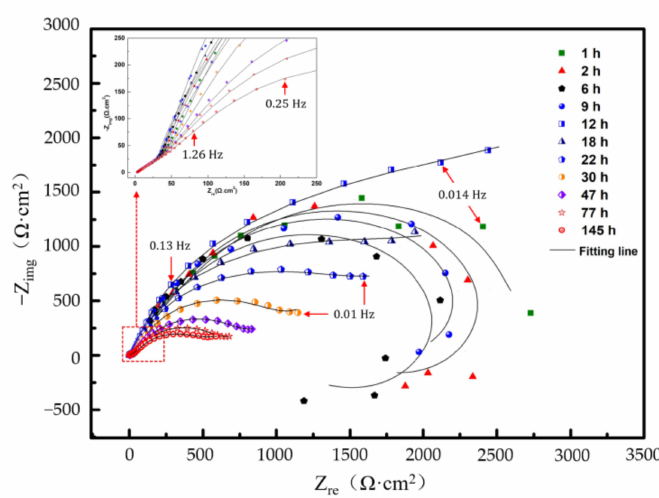
Figure 7. Nyquist plots of the Al–BN ACS with different immersion